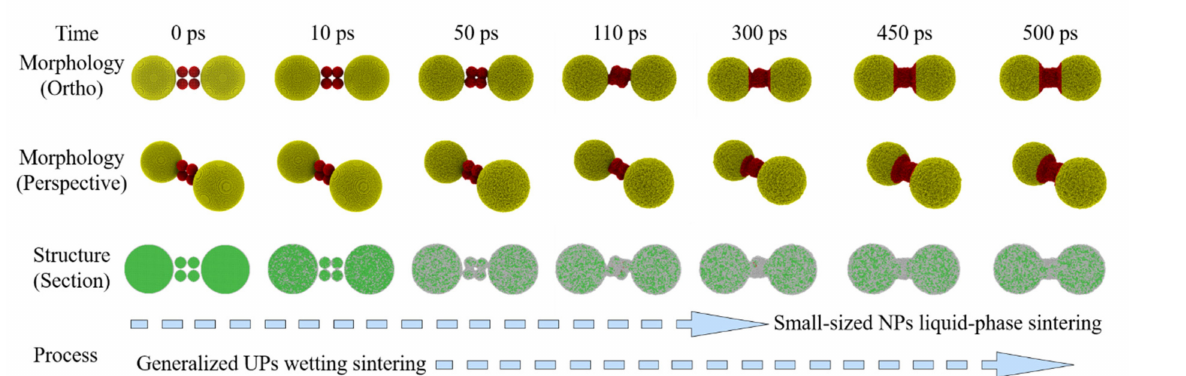
Figure 18. Sintering process for a simplified-model MPs-520, which represents the UPs-like structure in